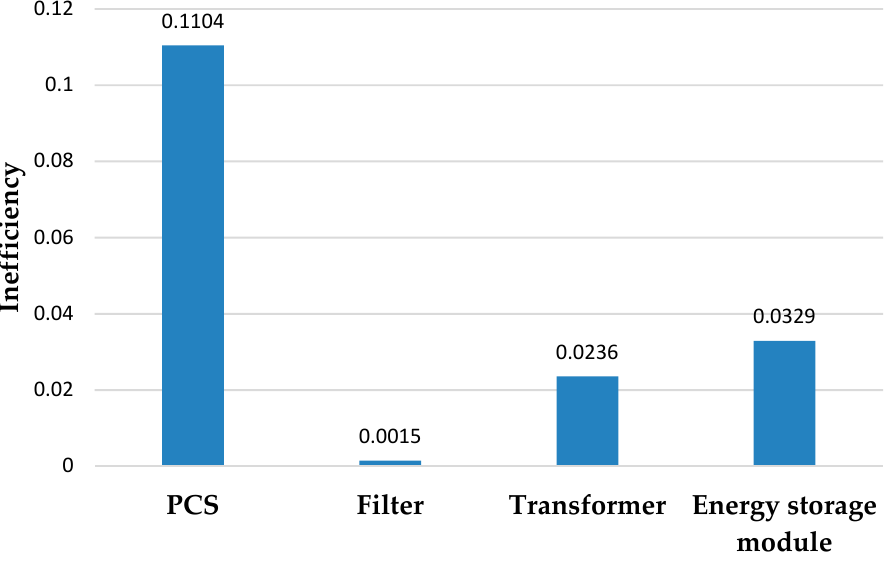
Figure 3. Inefficiency of power electronic components.